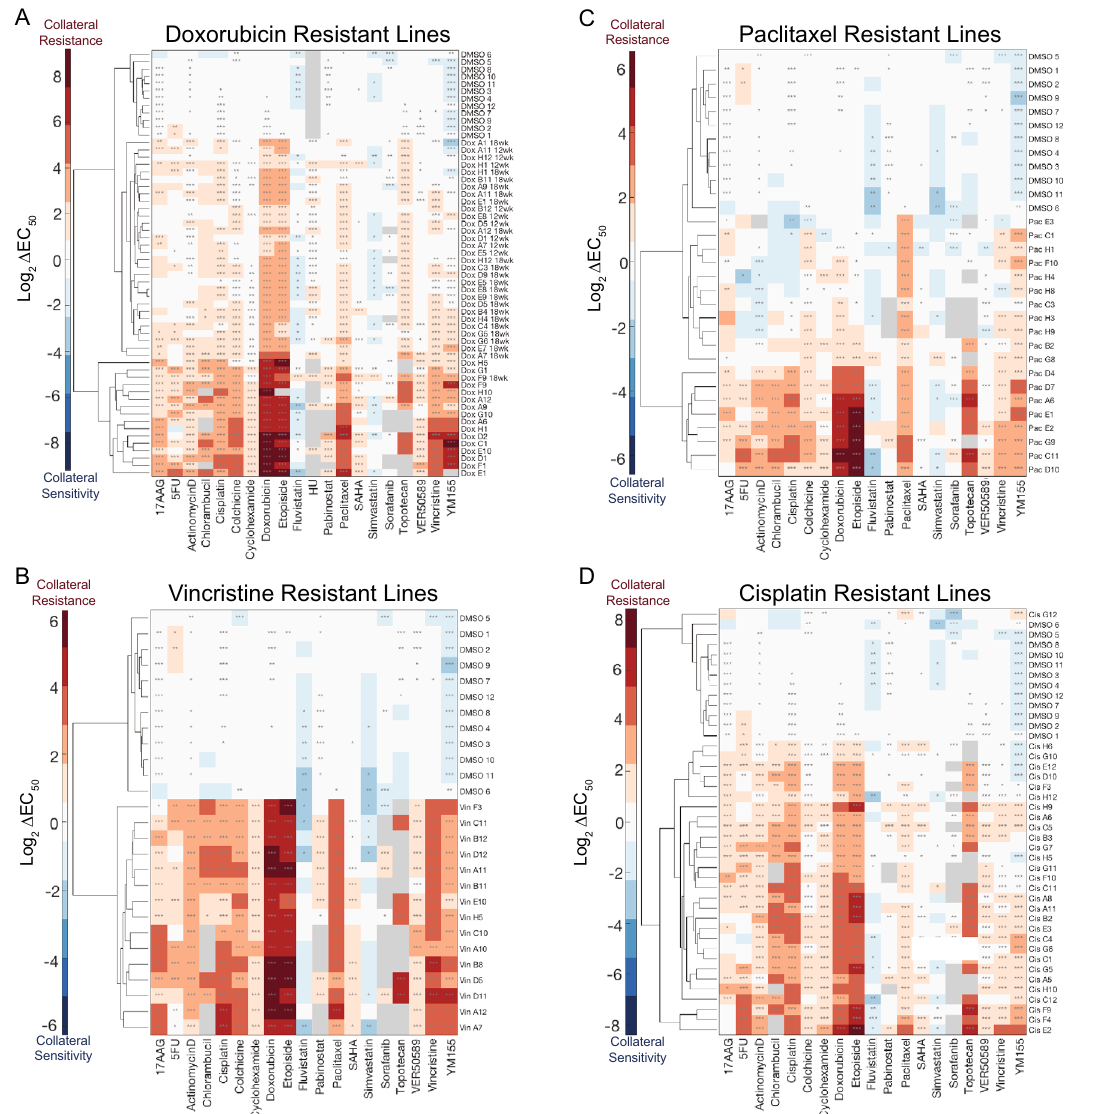
Figure 4. Collateral effects of acquiring resistance to (A) doxorubicin, (B) vincristine, (C) paclitaxel, and (D) cisplatin. In each plot, control cell lines cultured with DMSO instead of drug are shown at the top. Colors represent the log 2 fold change of the EC 50 of each cell line for a drug relative to the parental cell line’s EC 50 for that same drug. Data represent the mean of three biological replicates. *, P ≤ 0.05, **, P ≤ 0.01, ***, P ≤ 0.001 (two-sample t-tests with Bonferroni